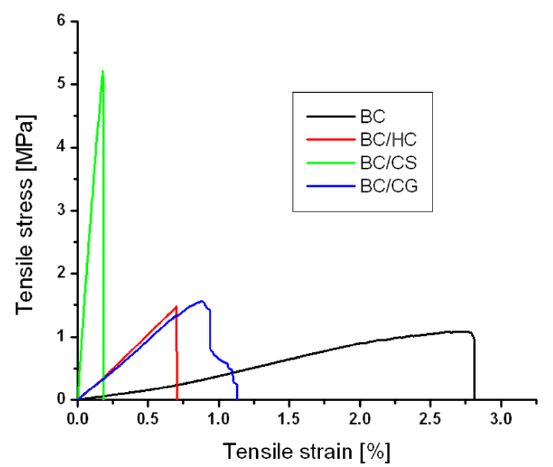
Figure 5. Strain – stress curves of lyophilized BC and BC/collagen composites. Table 1. Mechanical properties of lyophilized BC and BC/collagen composites.